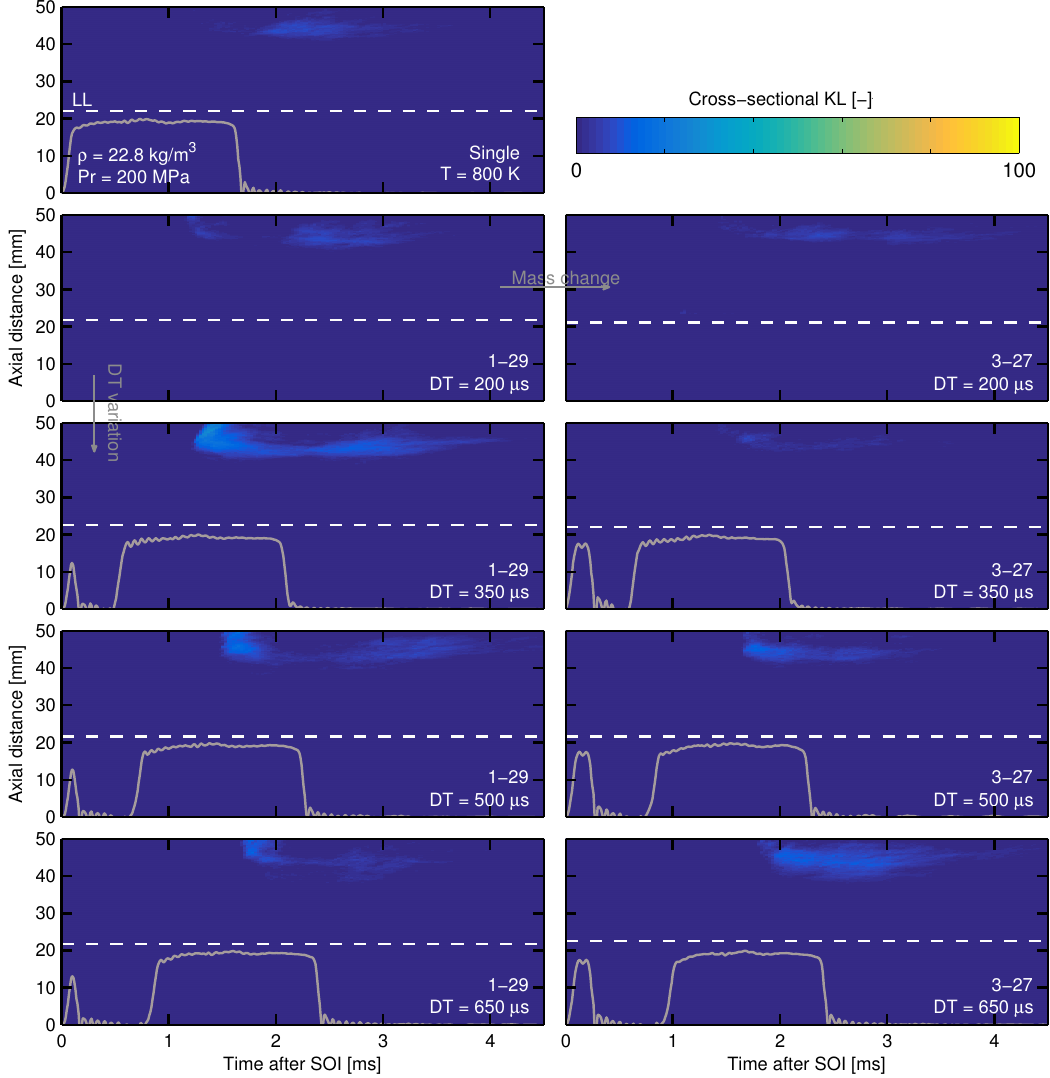
Figure 13. Evolution of the cross-sectional KL at each axial distance for pilot-main strategies, for a rail pressure of 200 MPa, a chamber density of 22.8 kg · m − 3 and temperature of 800 K. The dashed white lines depict the liquid length. The mass flow pulses [13] are plotted when they decoupled. Gray arrows represent the direction of the variable changed for